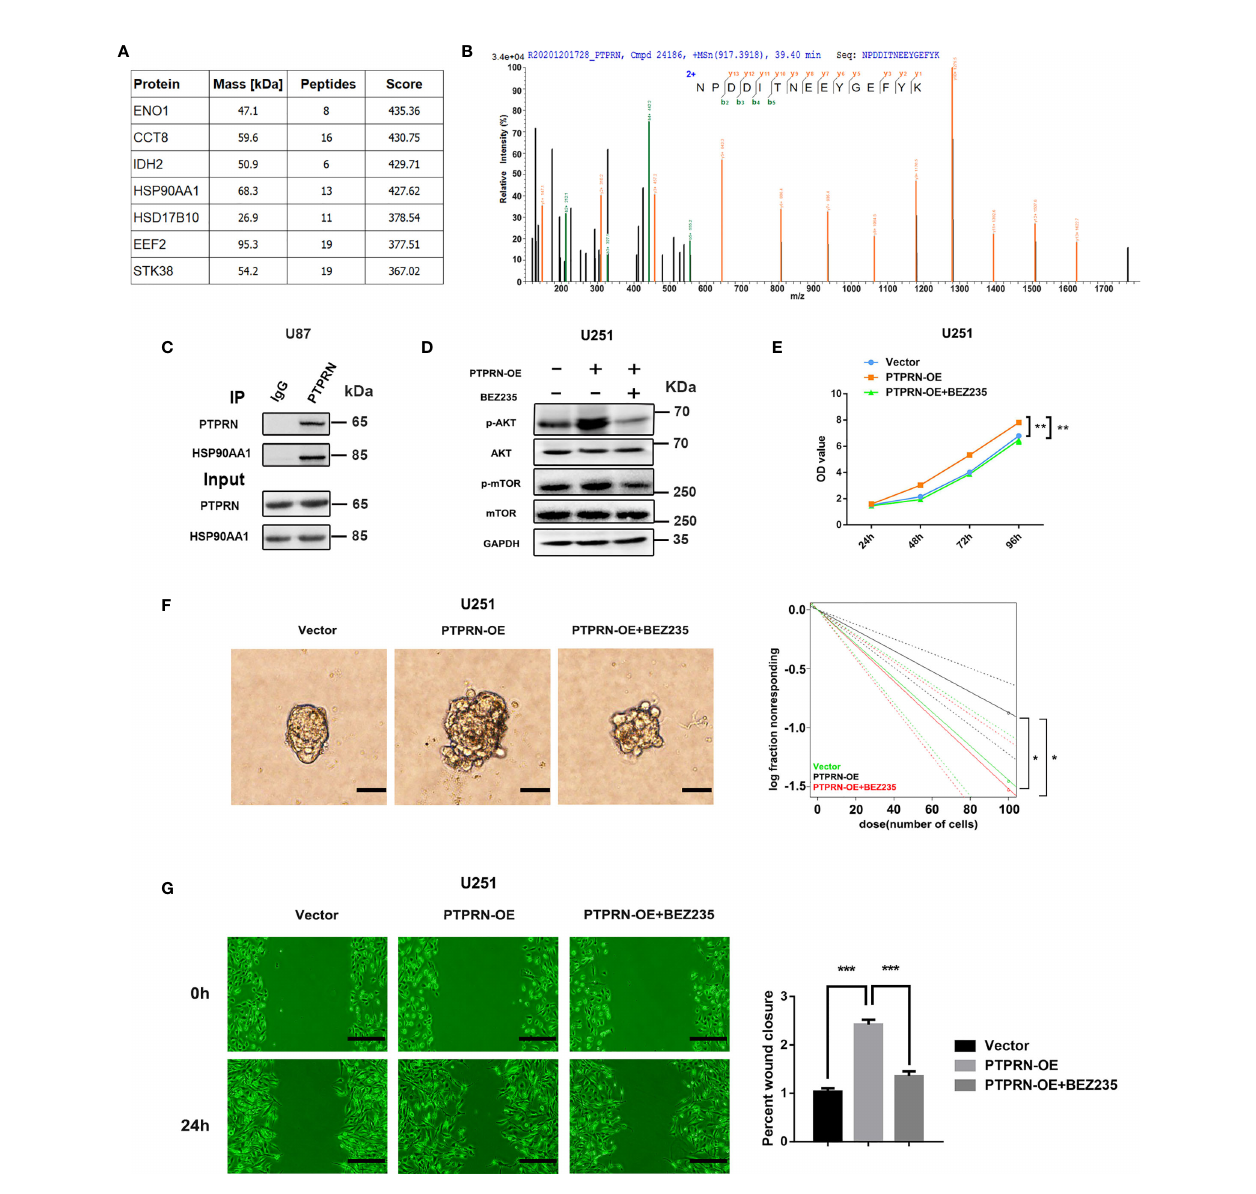
FIGURE 6 | PTPRN activated the PI3K/AKT pathway by interacting with heat shock protein 90 alpha family class A member 1 (HSP90AA1). (A) Differentially expressed proteins interacting with PTPRN were identi fi ed by Co-IP and LC-MS/MS from FLAG-HA-PTPRN-expressing 293T cells, including an interaction between PTPRN and HSP90AA1. (B) Secondary spectrogram of target peptide showed PTPRN bind with HSP90AA1 directly. (C) Immunoprecipitation and western blotting demonstrated that PTPRN interacted with HSP90AA1 in U87 cells; (D) BEZ235 was used to reverse PI3K/AKT pathway activity in U251 cells with overexpression of PTPRN. AKT, p- AKT, mTOR, and p-mTOR expression were shown by western blot; (E) Cell proliferation detected by CCK-8; the corresponding OD values were detected at 24 h, 48 h, 72 h and 96 h; (F) Sphere formation detected by microscope and calculated by ELDA after 14 days; (G) The migration of the cells detected by wound healing assay; the scratch was imaged at 0 and 24 h; The area of scratch reduction was calculated; scale bars, 100 m m; *p < 0.05, **p < 0.01, ***p <